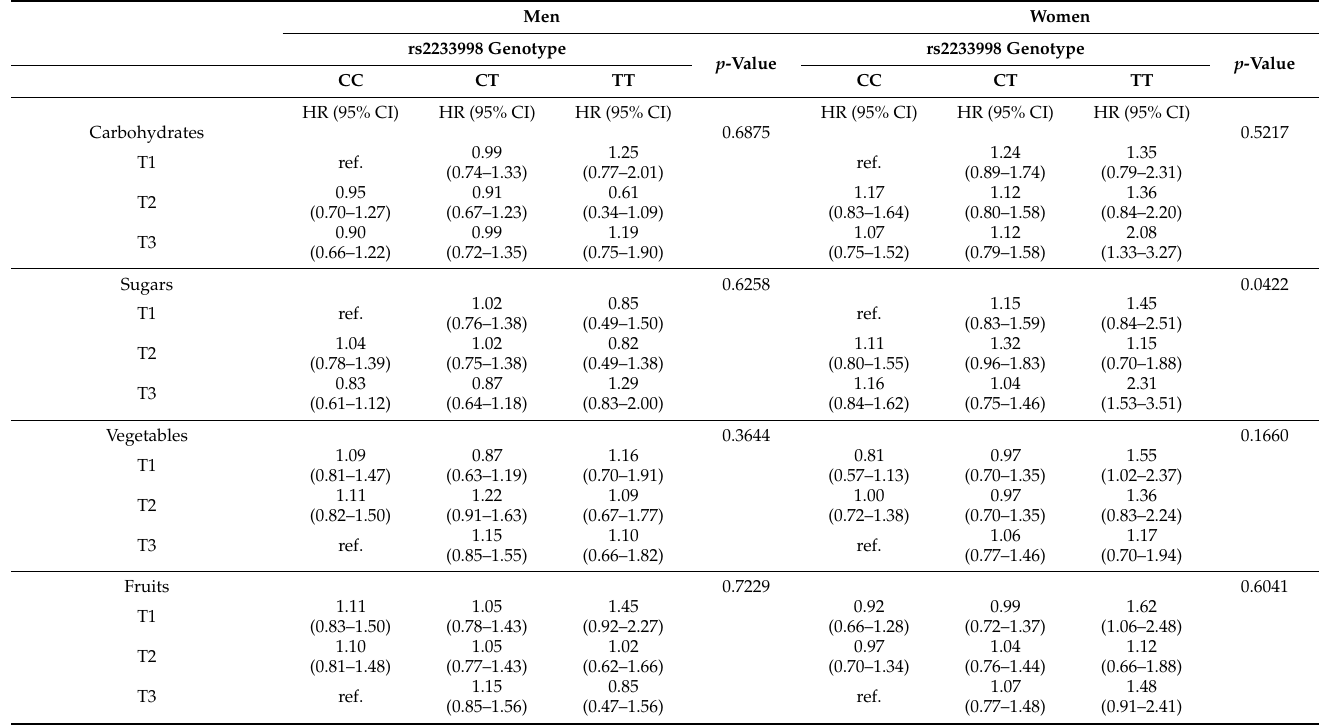
Table 5. Adjusted hazard ratios (with 95% confidence intervals) for type 2 diabetes mellitus according to TAS2R4 rs2233998 genotype and dietary intake. Men Women rs2233998